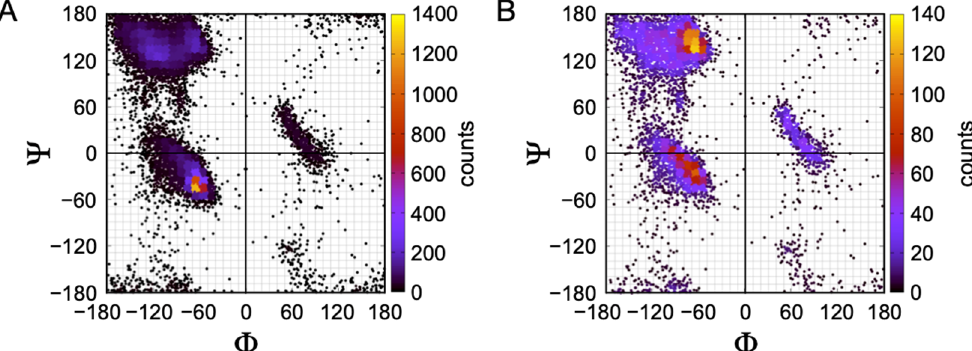
Figure 2. Protein coil libraries are dominated by PPII conformations. In total, 122 non-homologous human structures were analyzed for individual residue conformations (including Gly). ( A ) Ramachandran plot for every residue in the set (15,598 residues). The major population is in the α region, centered at ( − 65°, − 45°). ( B ) Ramachandran plot of the same set after removing all identified α -helix and β -sheet residues (identified using the information provided in the PDB structure file header), yielding 6418 remaining. The major population has shifted to the PPII region, and peaks at ( − 65°, 135°). For both plots, color represents the count in 10° × 10° bins.